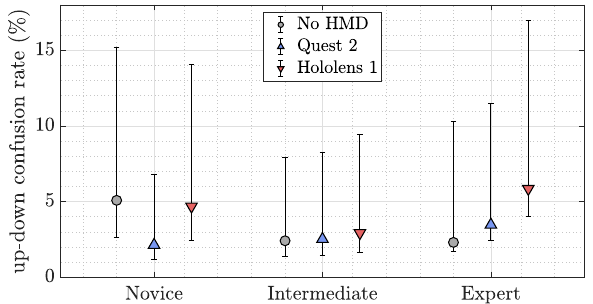
Figure 8. Up – down confusion rate across HMD conditions and participants self-reported localization